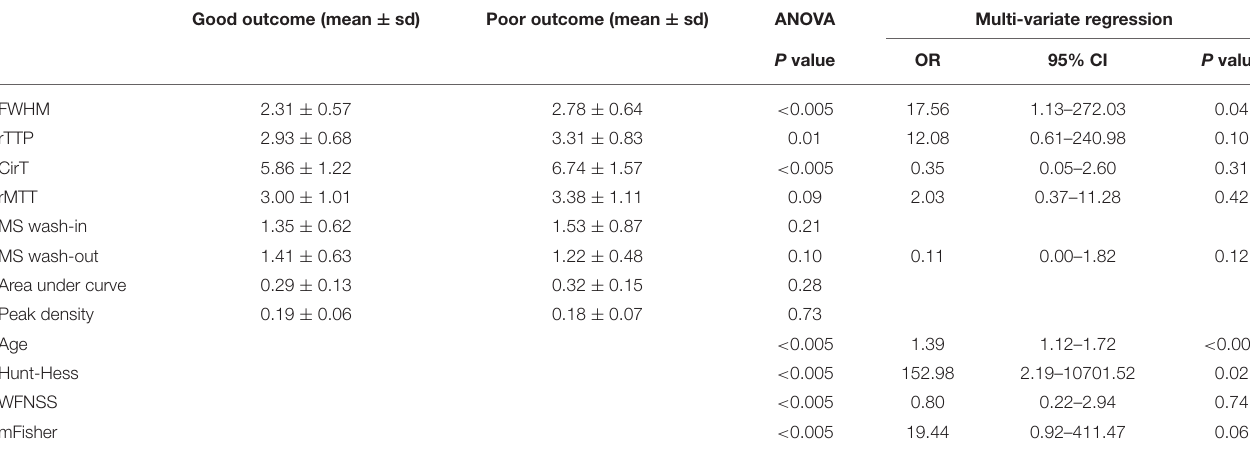
TABLE 3 | The multivariate logistic regression analysis of factors associated with outcome at discharge. Good outcome (mean ± sd) Poor outcome (mean ± sd) ANOVA Multi-variate